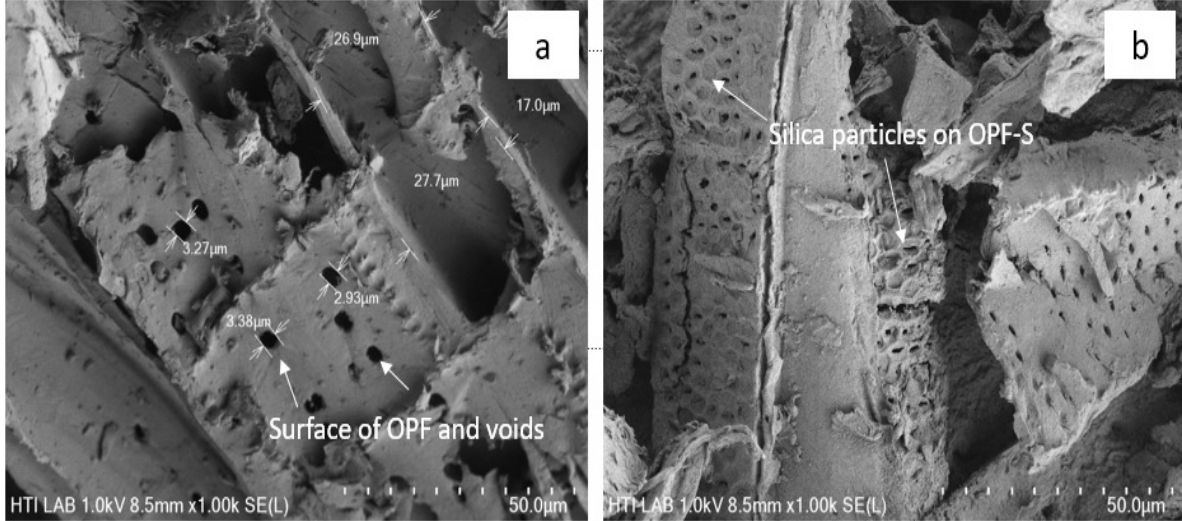
Figure 5. SEM images of the OPF ( a ) and OPF-S ( b ).